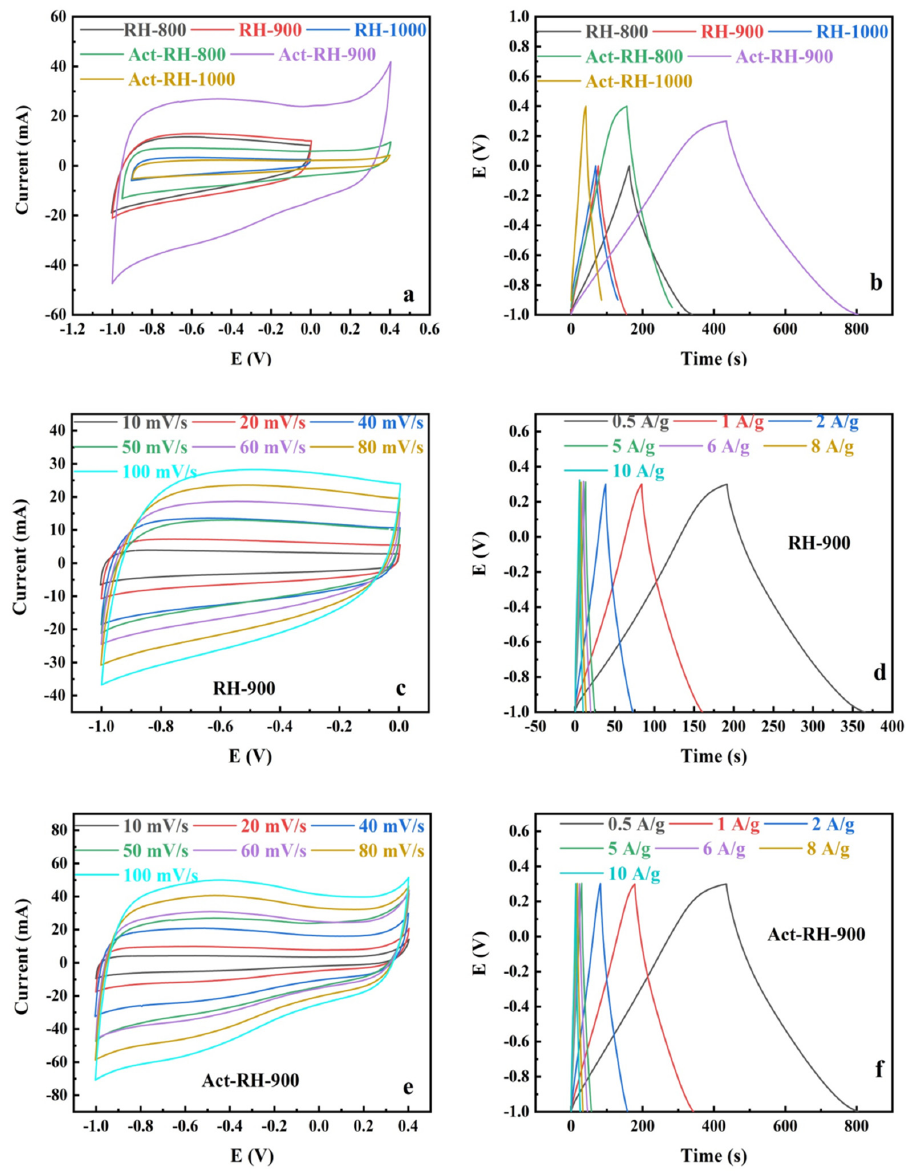
Figure 7. ( a ) CVs of all samples at a scan rate of 50 mV s − 1 . ( b ) GCD results for all samples. ( c ) CVs of RH-900 at scan rates from 10 to 100 mV s − 1 . ( d ) GCD results for RH-900 at current densities from 0.5 to 10 A g − 1 . ( e ) CVs of Act-RH-900 at scan rates from 10 to 100 mV s − 1 . ( f ) GCD results for Act-RH-900 at current densities from 0.5 to 10 A g − 1 . Table 3. The specific capacitance of Act-RH-900 and other materials.